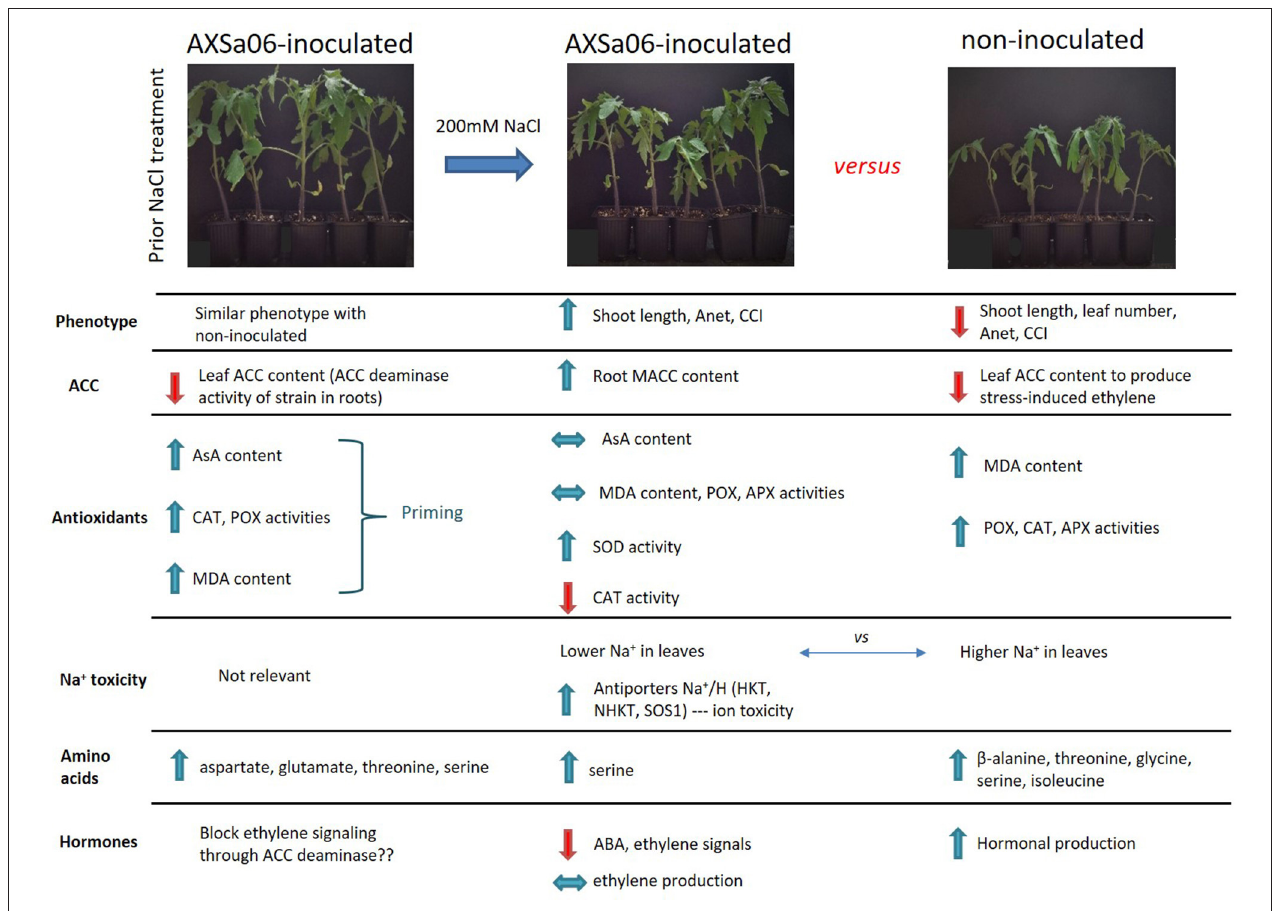
FIGURE 7 | Proposed model for AXSa06-mediated salt tolerance in tomato seedlings exposed to 200mM NaCl. Inoculation with AXSa06 imposed plants at a pre-conditioned state prior to stress application, by stimulating their antioxidant defense response, by blocking ethylene signals through the activity of ACC deaminase, as well as by enhancing amino acid synthesis. Upon salt stress exposure, AXSa06-inoculated plants showed improved growth and photosynthetic traits, as well as a reduced tendency for Na + uptake which is accompanied by enhanced transcript levels of Na + /H + antiporters. Furthermore, AXSa06 represses stress-inducing signals through a dampened ethylene and ABA metabolism, as well as reduced activation of downstream